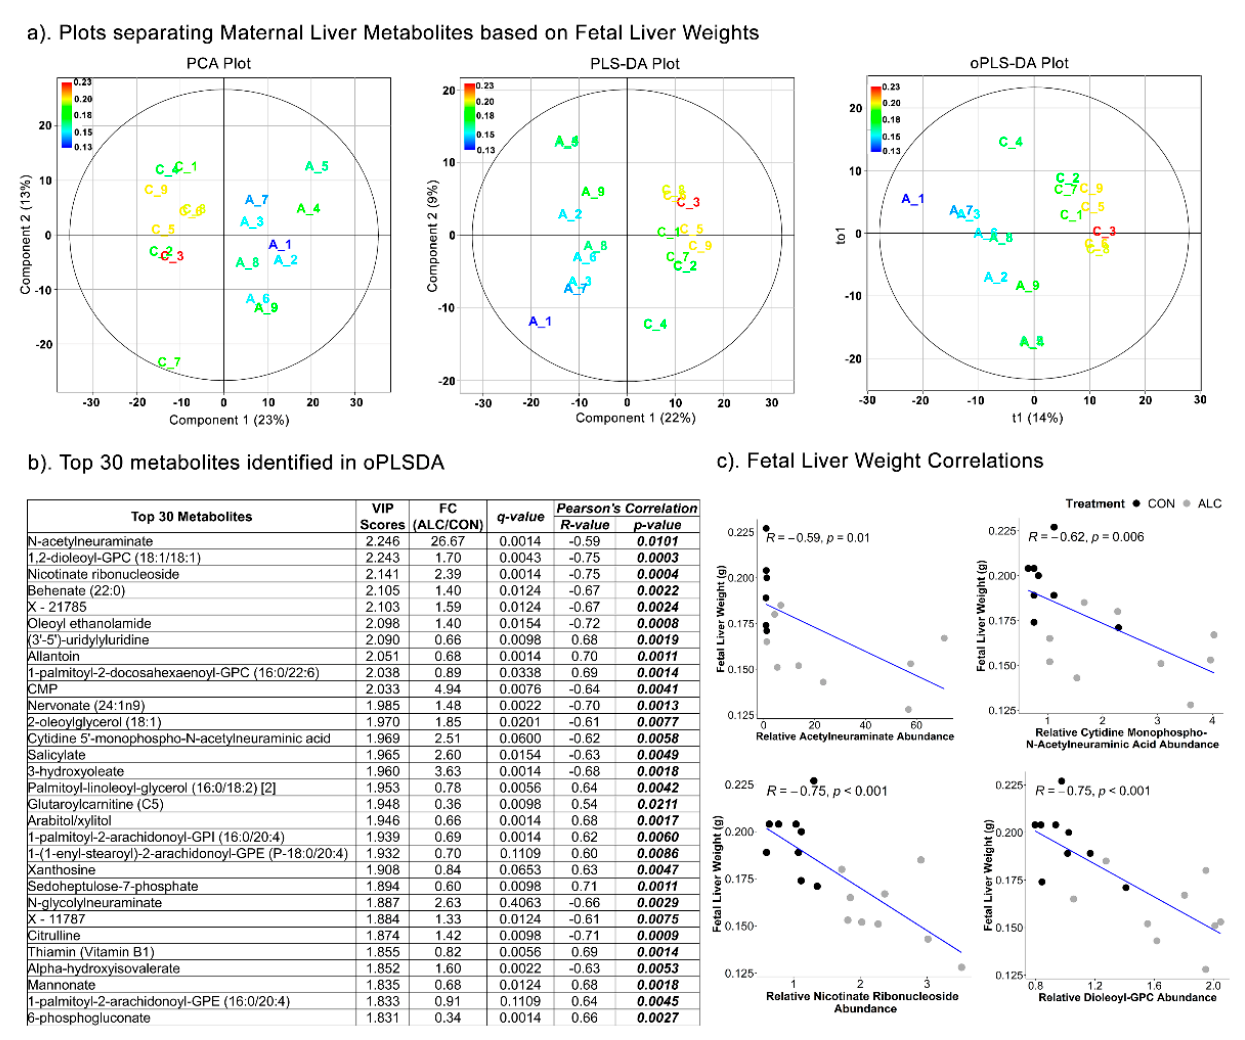
Figure 5. Separation of maternal liver metabolites as ALC vs. CON based on fetal liver weights. ( a ) PCA, PLS-DA, and oPLSDA plots depicting the separation of maternal liver metabolites as ALC vs. CON based on fetal liver weights. The legend and the corresponding color in the plots indicate in- crease in fetal liver weights (in g) values from blue to red. ( b ) The top 30 metabolites extracted as VIP scores in the first orthogonal component in oPLSDA with FC (ALC/CON), q-value, and Pear- son’s correlation (R) analysis with respect to fetal liver weights. Significant correlations at p ≤ 0.05 are bold and italicized. ( c ) Correlation plots of top select metabolites identified in oPLSDA with fetal liver weights. The blue trendlines indicate significant negative correlations.